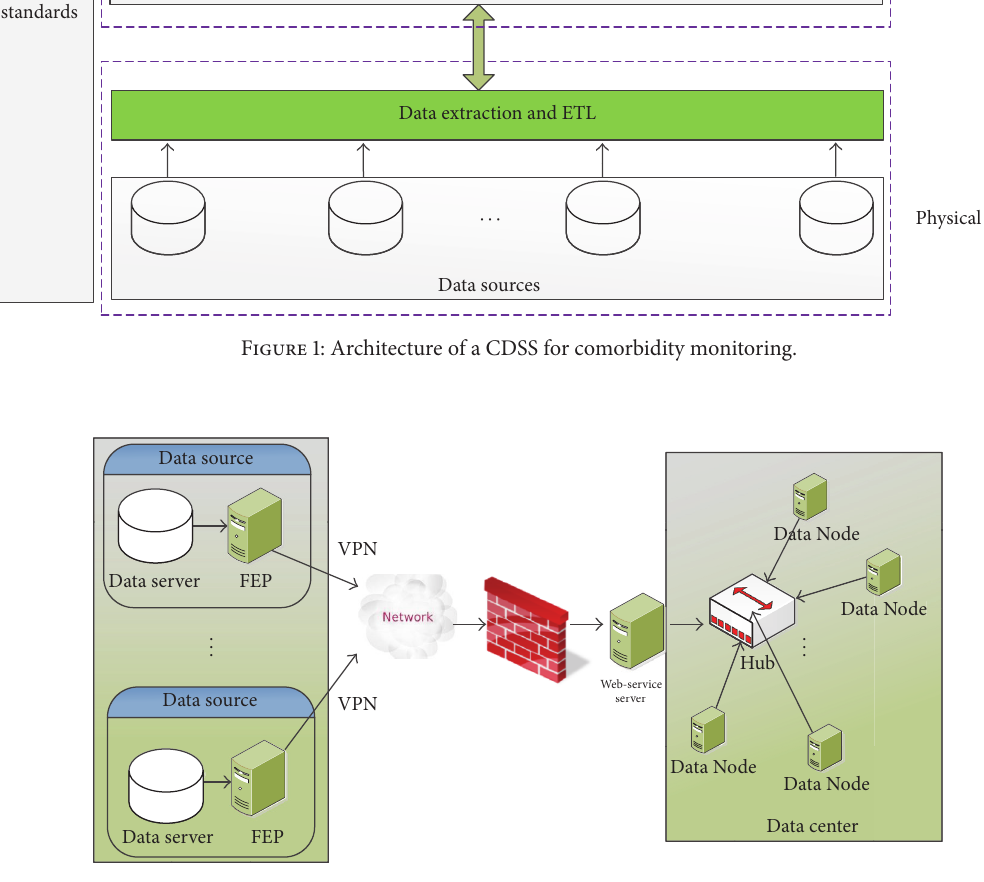
Figure 2: Physical layer of a